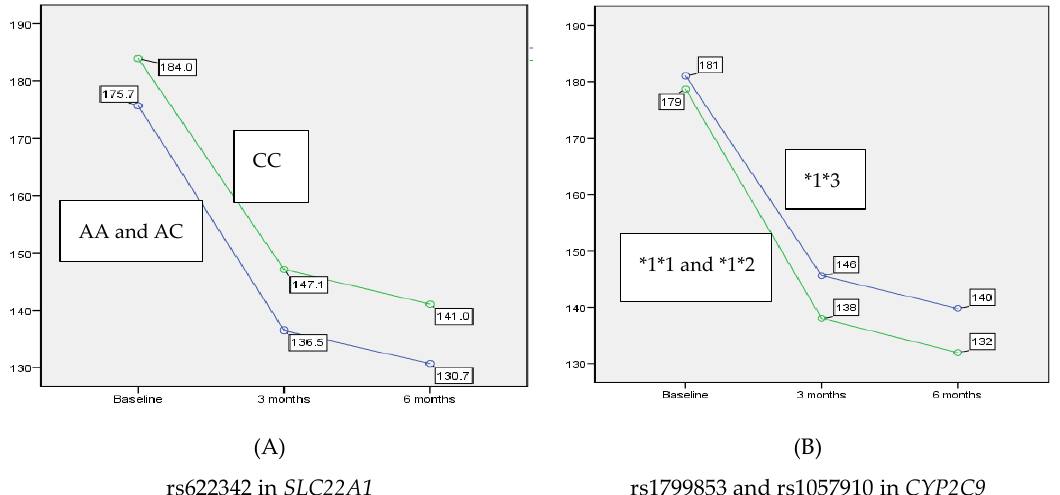
Figure 2. The main e ff ect of rs622342 in SLC22A1 and rs1799853 / rs1057910 in CYP2C9 on reducing the average of FBS after 3 and 6 months. rs622342 in SLC22A1 was negatively associated with FBS ( p = 0.021). rs1799853 and rs1057910 in CYP2C9 did not show any significant e ff ect on FBS levels ( p = 0.156). HbA1c: glycated hemoglobin; FBS: fasting blood sugar. All lipid levels decreased over 3 and 6 months of combinational therapy (Table 2), yet neither an association nor an interaction between rs622342 in SLC22A1 , CYP2C9 *2 and CYP2C9 *3 were detected over any of the lipid levels ( p >